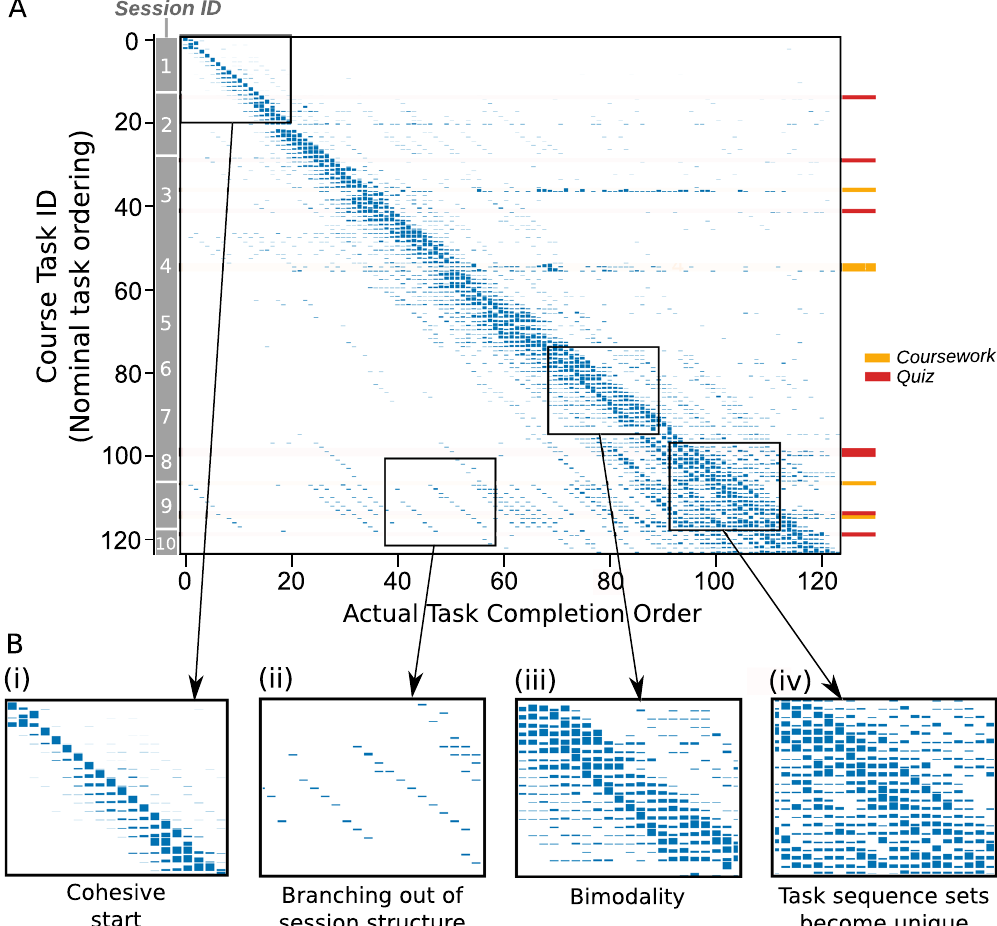
Figure 3. ( A ) 2D-histogram compiling the probabilities of task completion for the 81 learners. The y -axis denotes the course task ID, i.e., the nominal completion order. Each task is part of a weekly session. The x -axis displays the point in the learners’ sequence in which that task was actually completed. Some of the key task types (coursework, quiz) are indicated by colours. ( B ) Each insert shows a magnification of a different part of A: (i) the beginning of the course; (ii) large deviations from the nominal task order later on; (iii) bimodality of responses for particular tasks; and (iv) the broad distributions of task completion towards the end. Note also the wider spread in coursework and quiz